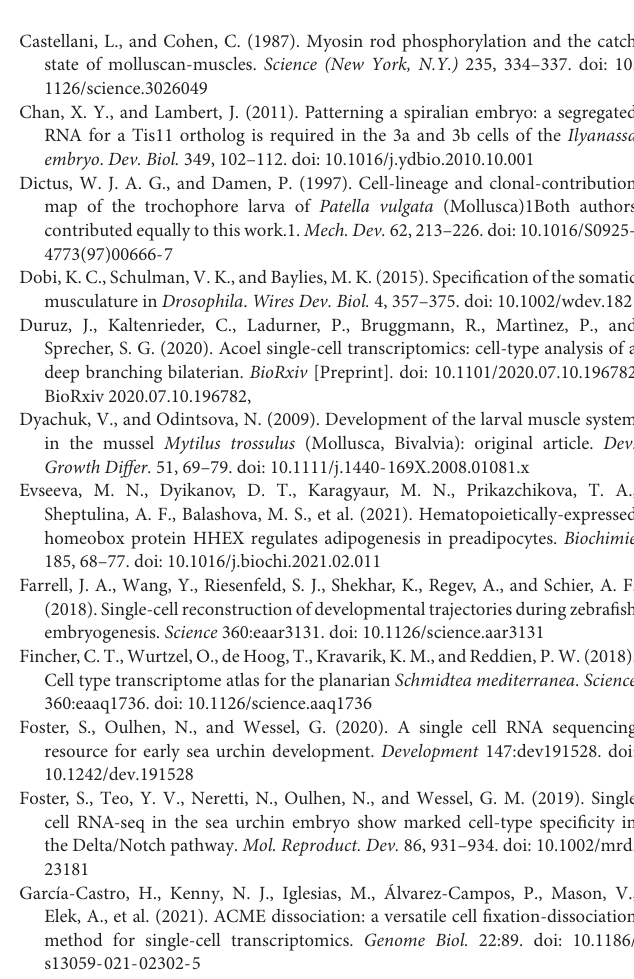
Supplementary Figure 5 | Negative controls (sense riboprobes) of in situ hybridization experiments for each randomly sampled marker gene used for cluster annotation. (A–C) Lateral views of mhc, hic31, and tsh, respectively. Anterior (A), posterior (P), ventral (V), and dorsal (D). Scale bars are 20 µ m. Dotted lines indicate the outline of the shell field. Asterisk indicates the mouth opening on the left side. Supplementary Table 1 | Gene annotations of the transcriptome used for this dataset. Annotations from Pfam, PANTHER, GO terms, and BLASTX hit from human and Crassostrea gigas orthologs are indicated in each column accordingly. Supplementary Table 2 | Differentially expressed markers per cluster result from the output FindAllMarkers function with a cluster threshold set up to 0.5. Supplementary Table 3 | Top 10 differentially expressed markers per cluster result from the output FindAllMarkers function with a cluster threshold set up to 0.7. Supplementary Table 4 | List of primers and nucleotide sequence for each gene used for cloning. Forward and reverse primers used for amplifying each gene by PCR are indicated. Supplementary Table 5 | Explored cutoffs in the dataset and the number of remaining cells of each cluster after each filtering. Thresholds were set from more than 100 genes and less than 4000 to more than 500 genes and less than 2500, respectively. Dotted lines indicate the outline of the shell field and the symbol * indicates the mouth opening on the left